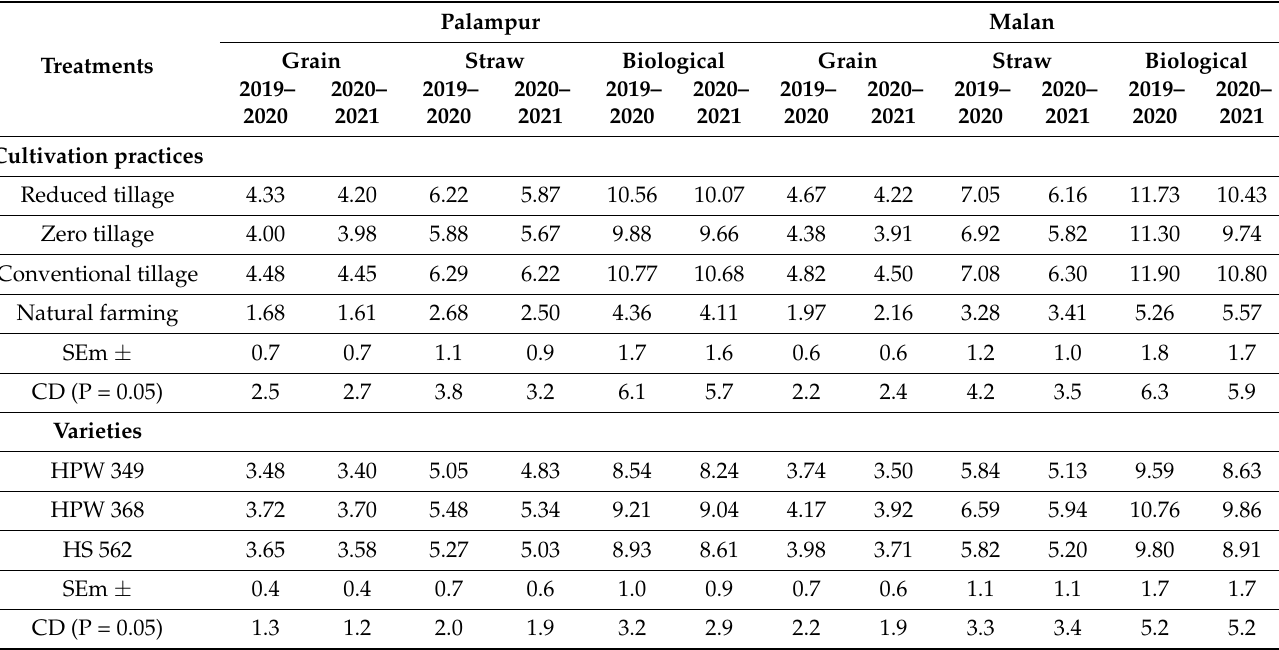
Table 1. Effect of cultivation practices on yield (t/ha) of different wheat varieties at Palampur and